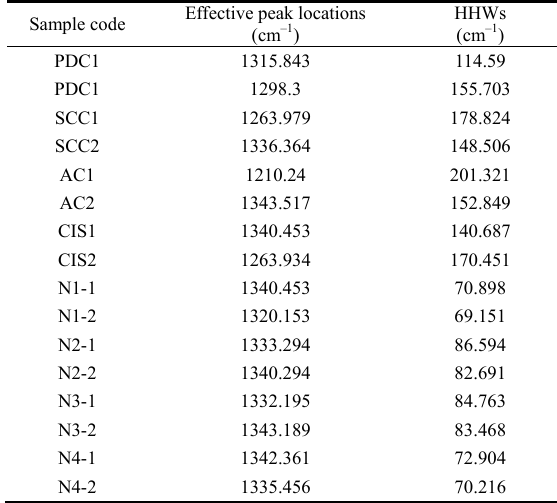
Table 1 Peak spectrum HHW of all specimens in a range of 1200 cm ‒ 1 ‒ 1400 cm ‒ 1 .